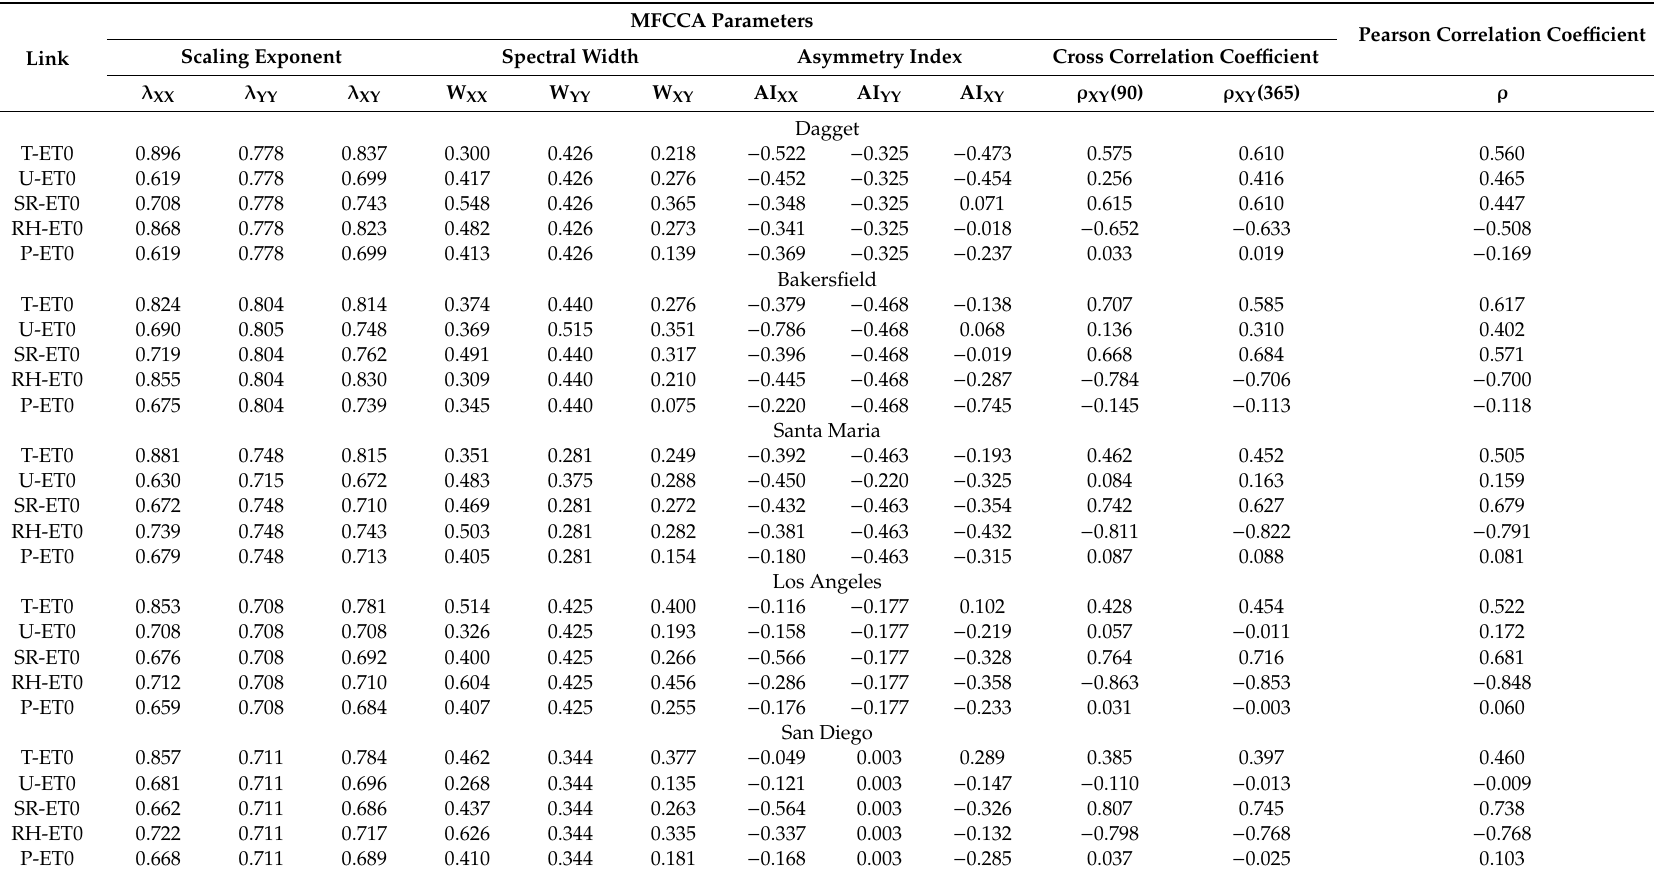
Table 3. MFCCA parameters of di ff erent agro-meteorological datasets of California, supplemented with Pearson correlation coe ffi cient ( ρ o